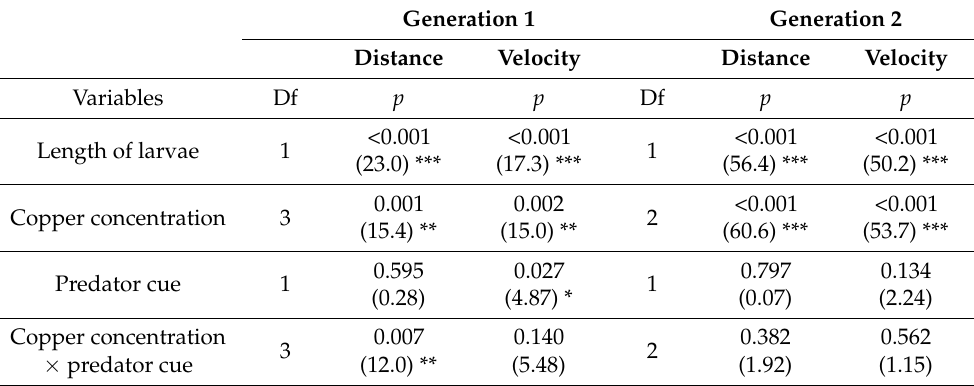
Table 1. Effects of copper exposure, predator cue and their interaction on distance and velocity for the first and second generations of Culex pipiens larvae. Length of larvae was added as a covariate. p -values and Wald Chi-squared statistic (in parentheses) for each variable. Significance is